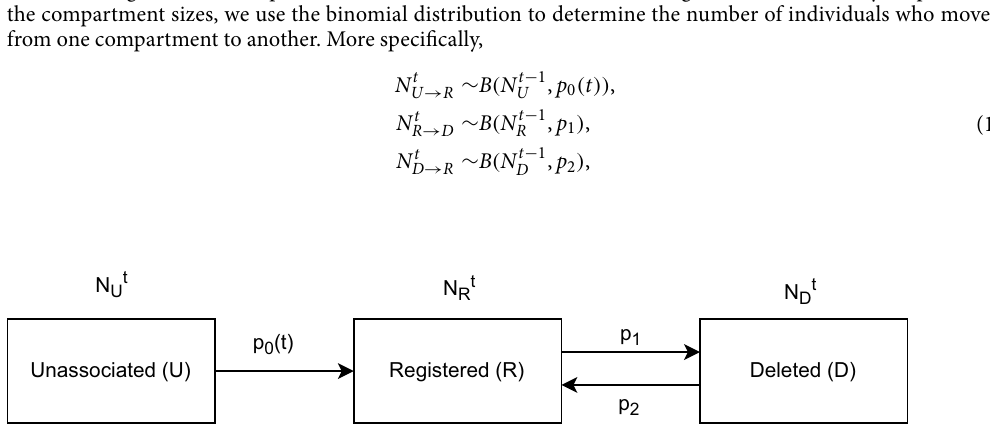
Figure 1. A schematic diagram of the compartmental model used for updating nodes of the